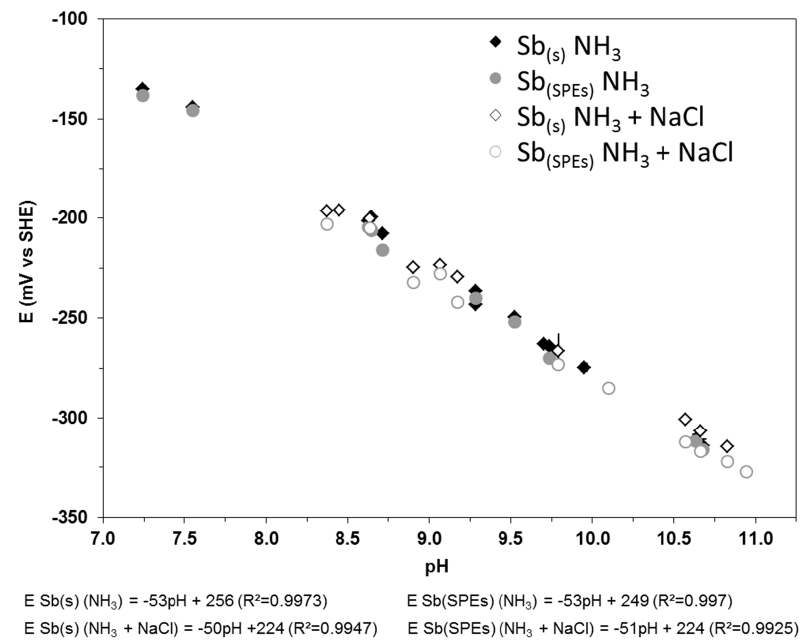
Figure 4. Eh-pH diagram of both the monocrystalline antimony electrode (Sb(s)) and antimony-based screen-printed electrodes (Sb(SPEs)) in ammonia pH buffer solutions, in the absence or presence of 0.1 M NaCl (25 °C, at atmospheric pressure).